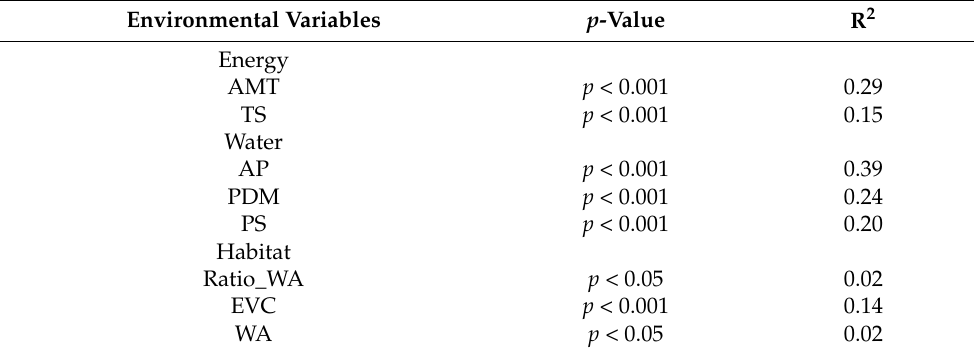
Figure 4. Elevation ( a ), latitude ( b ), and longitude ( c ) patterns of wetland angiosperms in the Qinghai-Tibet Plateau. LM model is used to fit the data, and the shaded areas represent the 95% confidence interval (N = 166). Table 1. Correlation Analysis between species richness and three environmental variables: energy, water, and habitat.